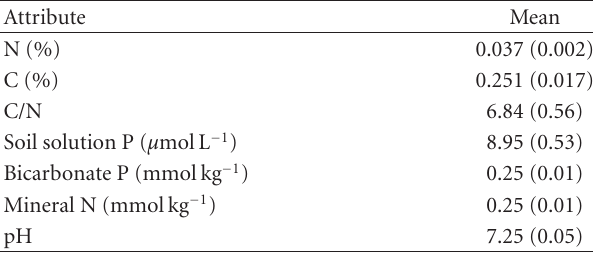
Table 2: Selected attributes of the soil before